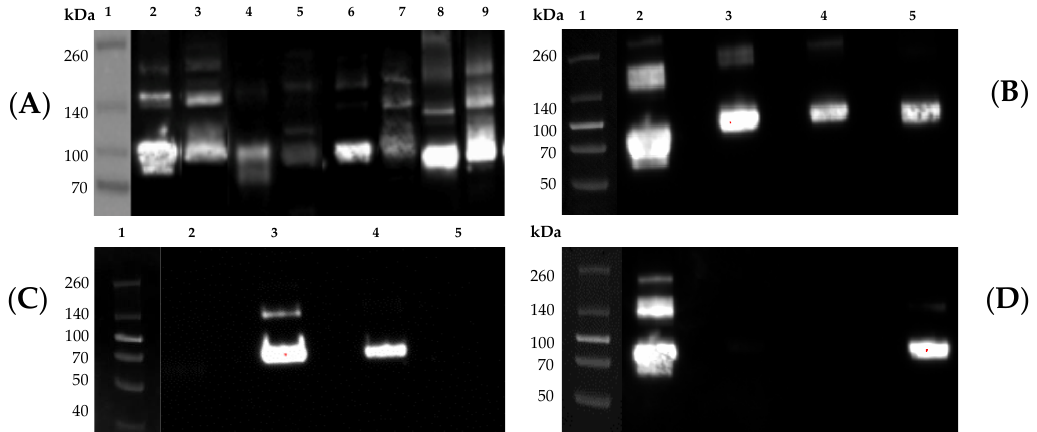
Figure 5. Representative western blot images of purified recombinant proteins expressed by stably-transfected cell lines and corresponding influenza virus HA and NA. ( A ) In lane 1: